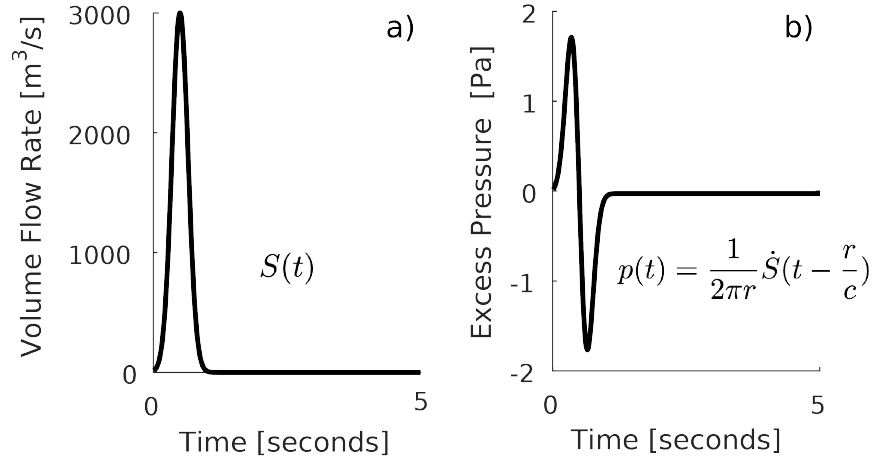
Figure 5. Modelling according to linear acoustic theory for a monopole source: ( a ) time-history of fluid injection into a uniform and homogeneous atmosphere (Gaussian); and ( b ) excess pressure time series at 1 km from the source, obtained as the time derivative of the source time function in ( a